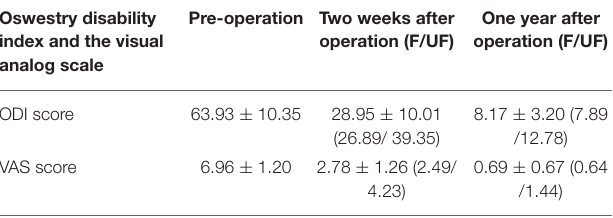
TABLE 2 | Description of changes in DOI and VAS